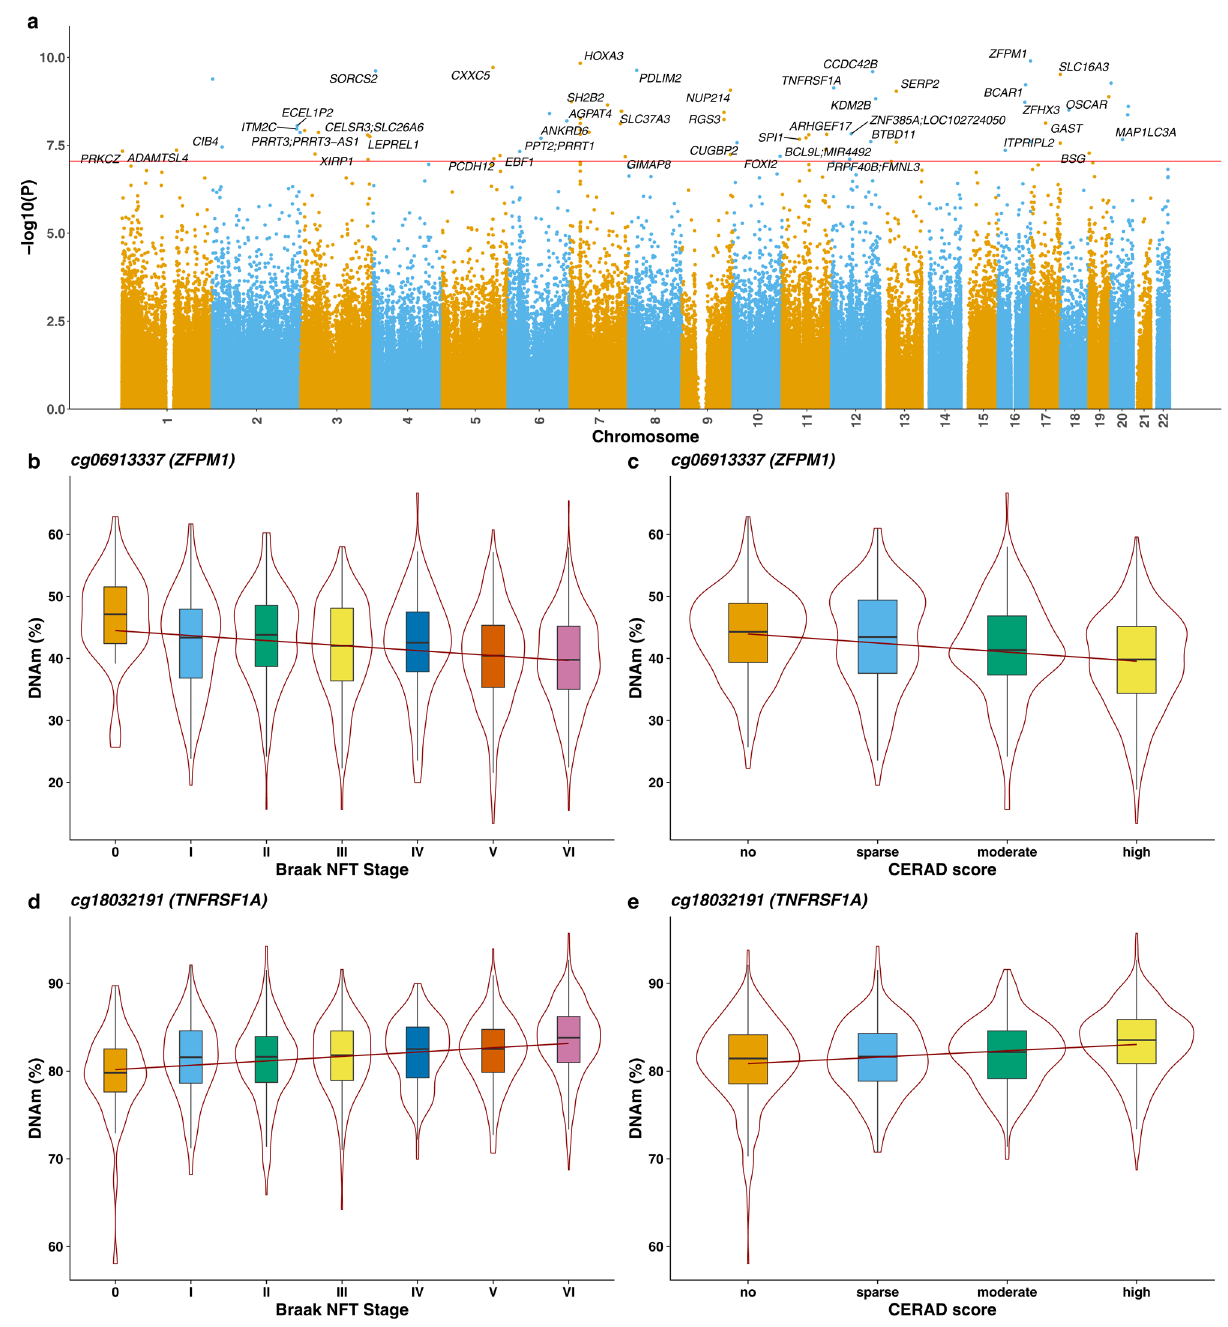
Fig.2|Differentiallymethylatedpositions(DMPs)inthecortexassociatedwith Alzheimer ’ s disease neuropathology. a Manhattan plot highlighting signi fi cant corticalDMPs associatedwith AD neuropathology (BraakNFTstage,CERAD score, Thalphase) ( N =631donors).In total 67 DMPs associated with AD neuropathology wereidenti fi edusinglinearregressionmodelscontrollingformajorcovariates(see Methods) at an experiment-wide signi fi cance threshold ( P <9E – 08). Genes